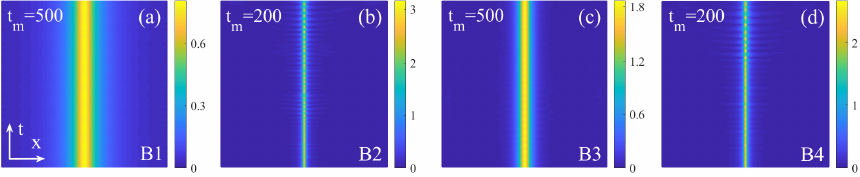
Figure 4. The perturbed evolution of the solitons corresponding to labels B1–B4 in Figure 3a,c. The respective values of the parameters are α = 1.1, g = 1, µ = − 0.2 ( a ); α = 1.1, µ = − 2 ( b ); α = 1.7, µ = − 1.5 ( c ); α = 1.1, µ = − 1.5 ( d ). The evolution is plotted in the spatial domain − 10 < x < + 10. Values t m indicate intervals of the scaled propagation distance in the respective panels, 0 < z < t m . In panels ( a , c ), larger t m is taken to corroborate the full stability of the solitons. The plots are borrowed from Reference [47]